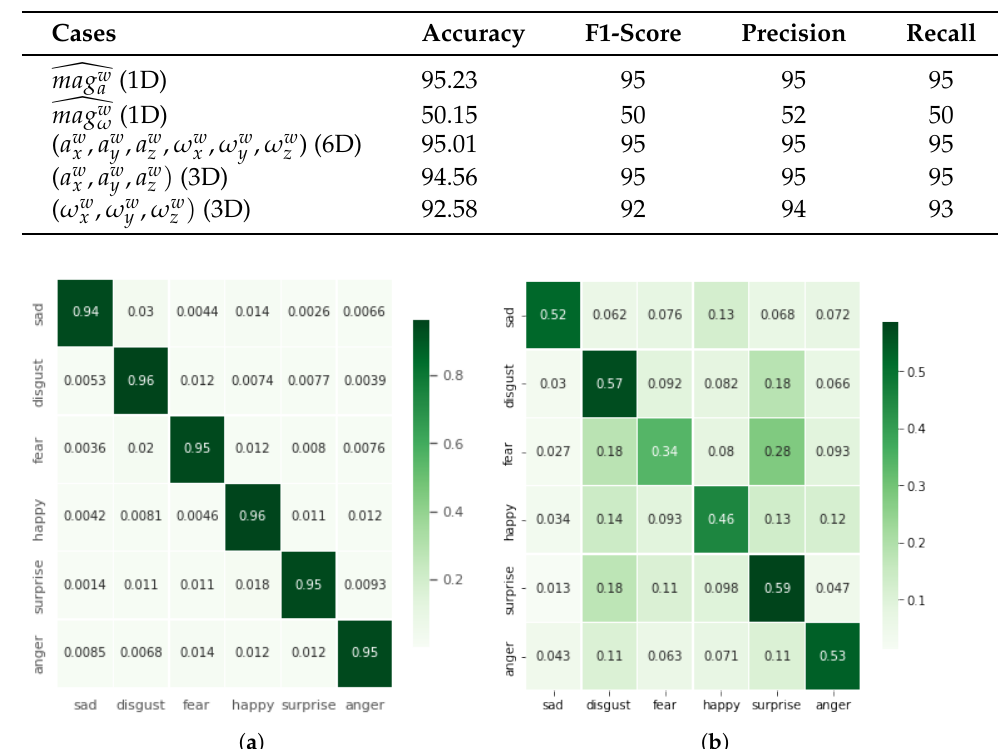
Table 2. Performance comparison between different input sizes used in the proposed model. The best results are produced with a magnitude of 3D accelerations. All of the values are in percentage (%).